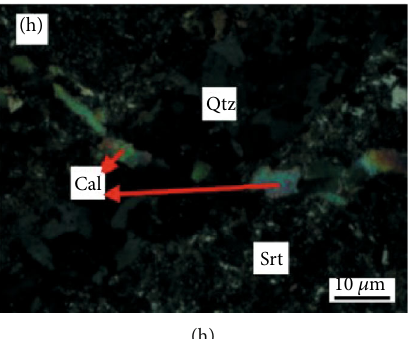
Figure 5: Photographs and microphotographs of wallrock alteration at Longmendian: (a – c) alteration styles and zoning; (d) quartz and calcite associated with silicic and calcite alterations (plane-polarized light); (e) fl aky mariposite; (f) chlorite associated with chloritization (plane-polarized light); (g) chlorite and sericite associated with chlorite and sericite alterations (cross-polarized light); (h) quartz, sericite, and calcite associated with silicic, sericite, and calcite alterations (cross-polarized light). Mrp: mariposite; Chl: chlorite; Qtz: quartz; Srt: sericite; Cal: calcite; Pl: plagioclase; Ms: muscovite; Bt: biotite; Am: amphibole; Zrn: zircon.